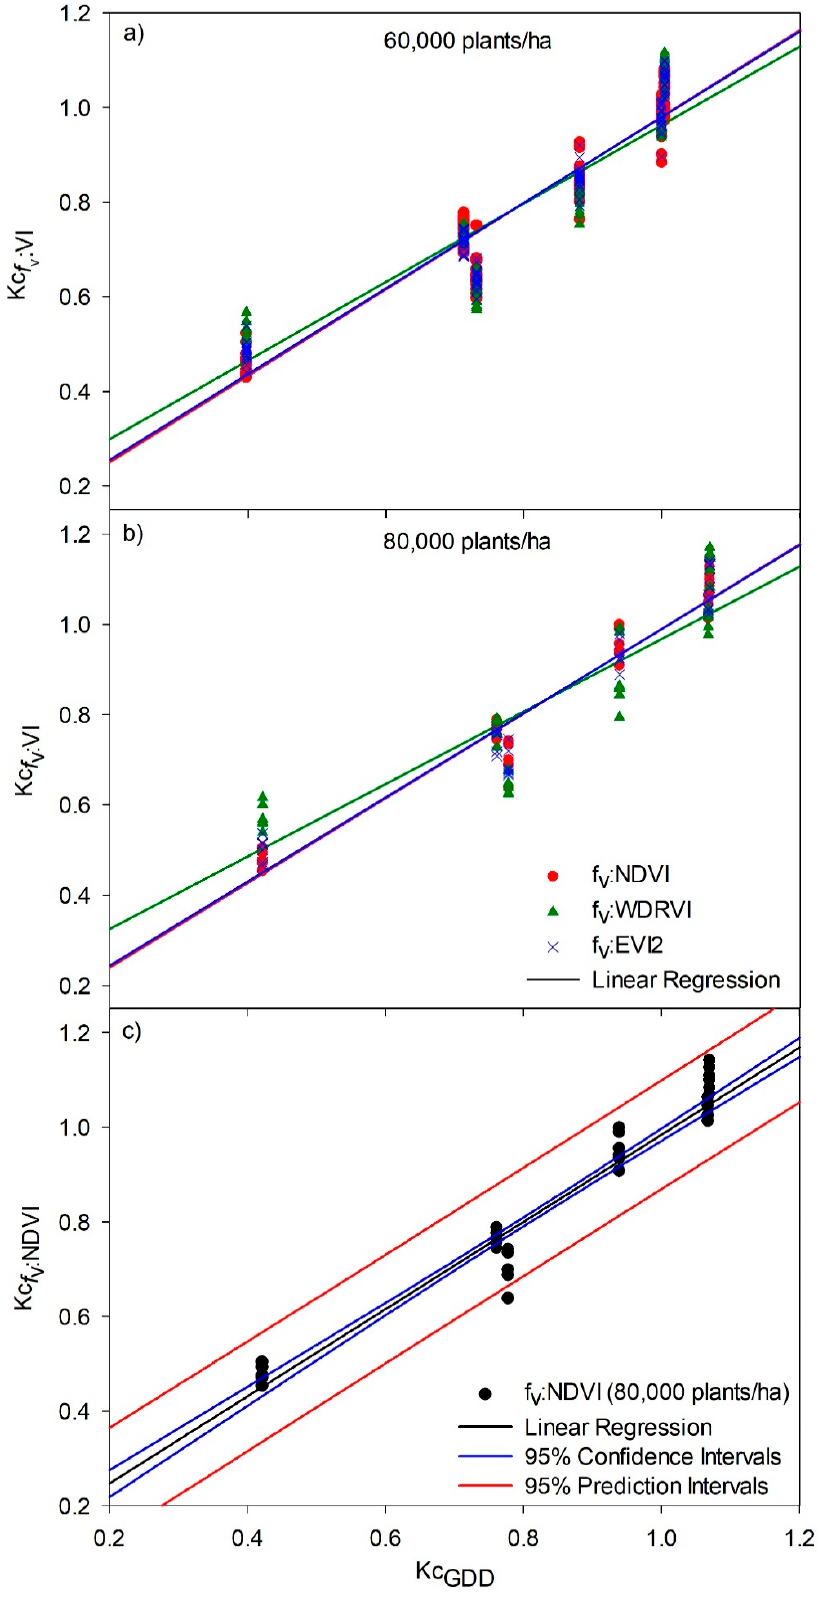
Figure 8. Validation of the Kc f v:VIs models as a function of Kc GDD for two plant densities ( a ) 60,000 plants/ha and ( b ) 80,000 plants/ha. and ( c ) 95% Confidence and prediction intervals for Kc f v:NDVI values for 80,000 plants/ha.